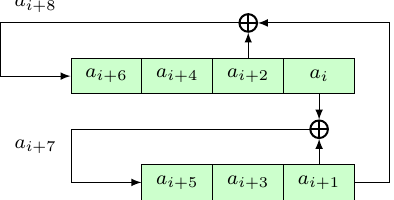
Figure 4: The LFSR generating WAGE round